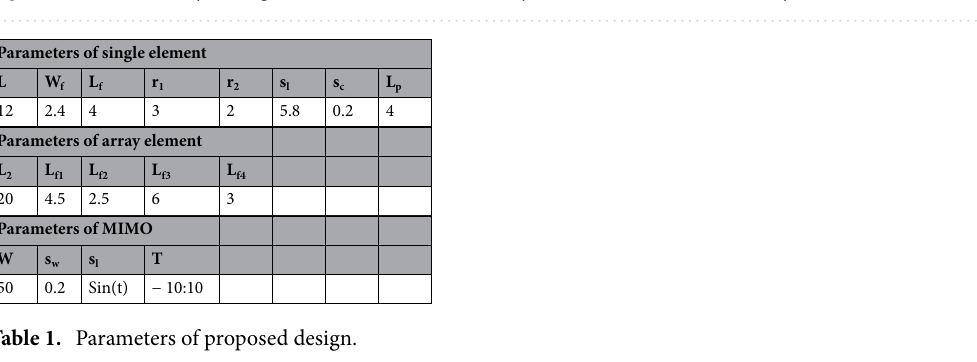
Figure 1. ( a ) Geometry of single element. ( b ) Antenna array front view. ( c ) Antenna array back view.